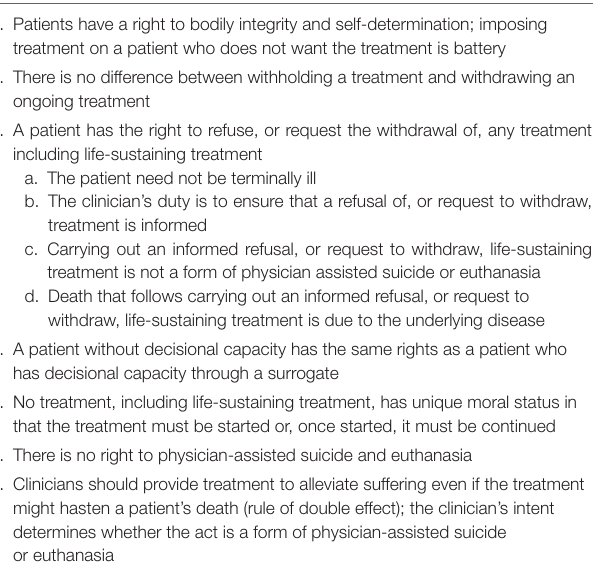
TABLE 1 | Precedents of landmark U.S. court cases regarding the permissibility of carrying out informed refusals of, or requests to withdraw, life-sustaining treat